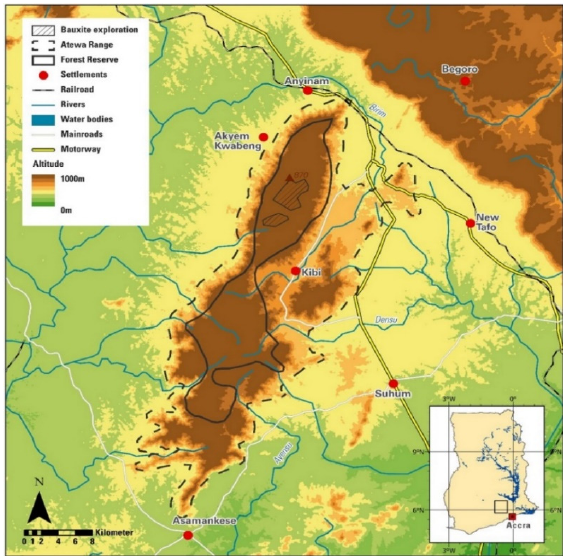
Figure 1. Map of the Atiwa Forest Reserve (study area). Source: A Rocha Ghana [26].